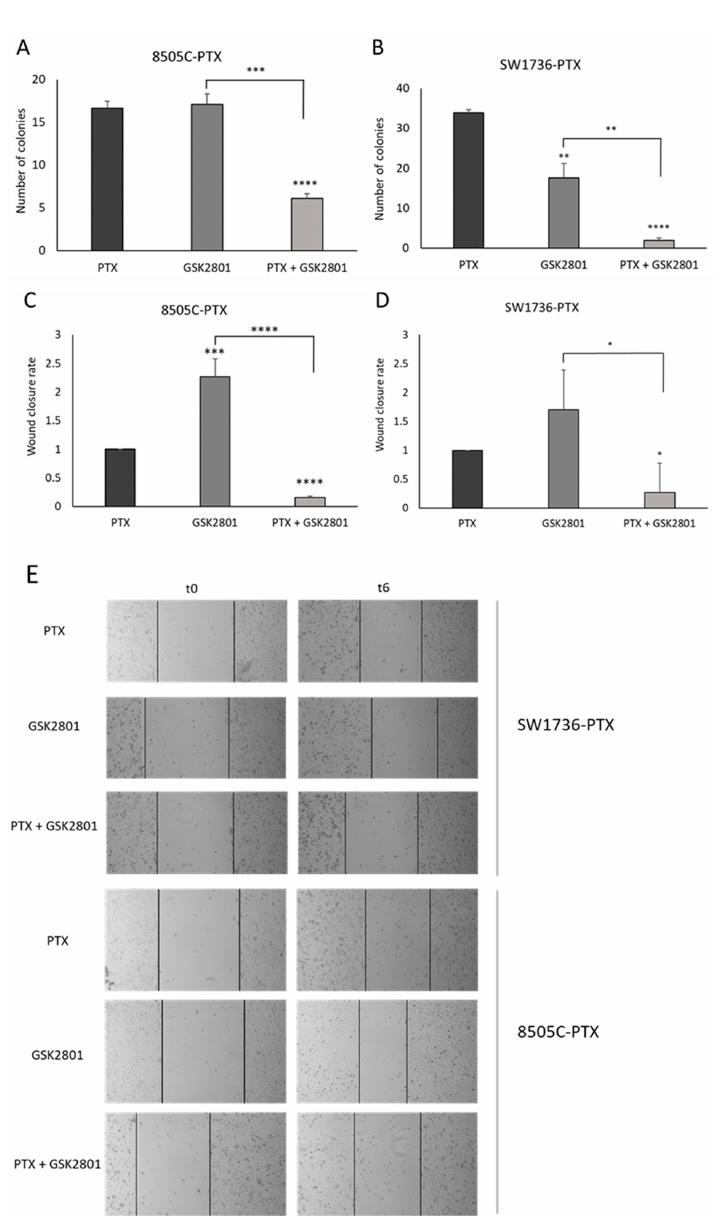
Figure 4. Effects of GSK2801 treatment on the aggressive behavior of cancer cells. The effect of GSK2801 on the ability to form colonies in an anchorage-independent way was measured by soft agar assay. The data obtained in 8505C-PTX cells are shown on the left panel ( A ), while on the right panel ( B ) the data obtained in SW1736-PTX cells are shown, following single treatment (paclitaxel alone here reported as PTX and GSK2801 alone) or combined treatment (PTX + GSK2801). The histograms represent the number of colonies per cell line. Data are representative of 3 independent experiments. ( C , D ) Evaluation of the ability of cells to migrate under the same conditions of soft agar assay, data obtained by wound healing assay. The wound closure rate was calculated measuring the difference in wound width (WW) at time zero (t0) and after 6 h (t6). The formula used is as follows: Wound closure rate = ( WWt 0 − WWt 6) treatment ÷ ( WWt 0 − WWt 6) control n = 4. ( E ) Photos showing wound margins (continuous black lines) at the beginning of migration (t0) and after 6 h (t6). * p < 0.05, ** p < 0.01, *** p < 0.001, **** p <